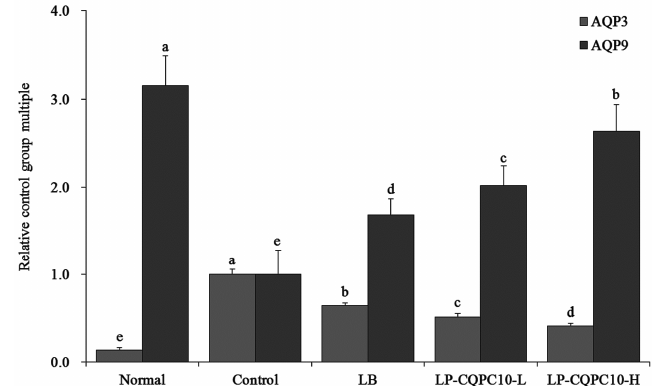
Figure 8. mRNA expression levels of AQP3 and AQP9 and CAT in the small-intestine tissue of mice. Values presented are the mean ± standard deviation. a–e Mean values with different letters in the same bars are significantly different ( p < 0.05) according to Duncan’s multiple-range test. LB: Lactobacillus bulgaricus (1.0 × 10 9 colony-forming unit (CFU)/kg body weight (bw)); LP-CQPC10-L: Lactobacillus plantarum CQPC10 (1.0 × 10 8 colony-forming unit (CFU)/kg body weight (bw)); LP-CQPC10-H: Lactobacillus plantarum CQPC10 (1.0 × 10 9 colony-forming unit (CFU)/kg body weight (bw)).